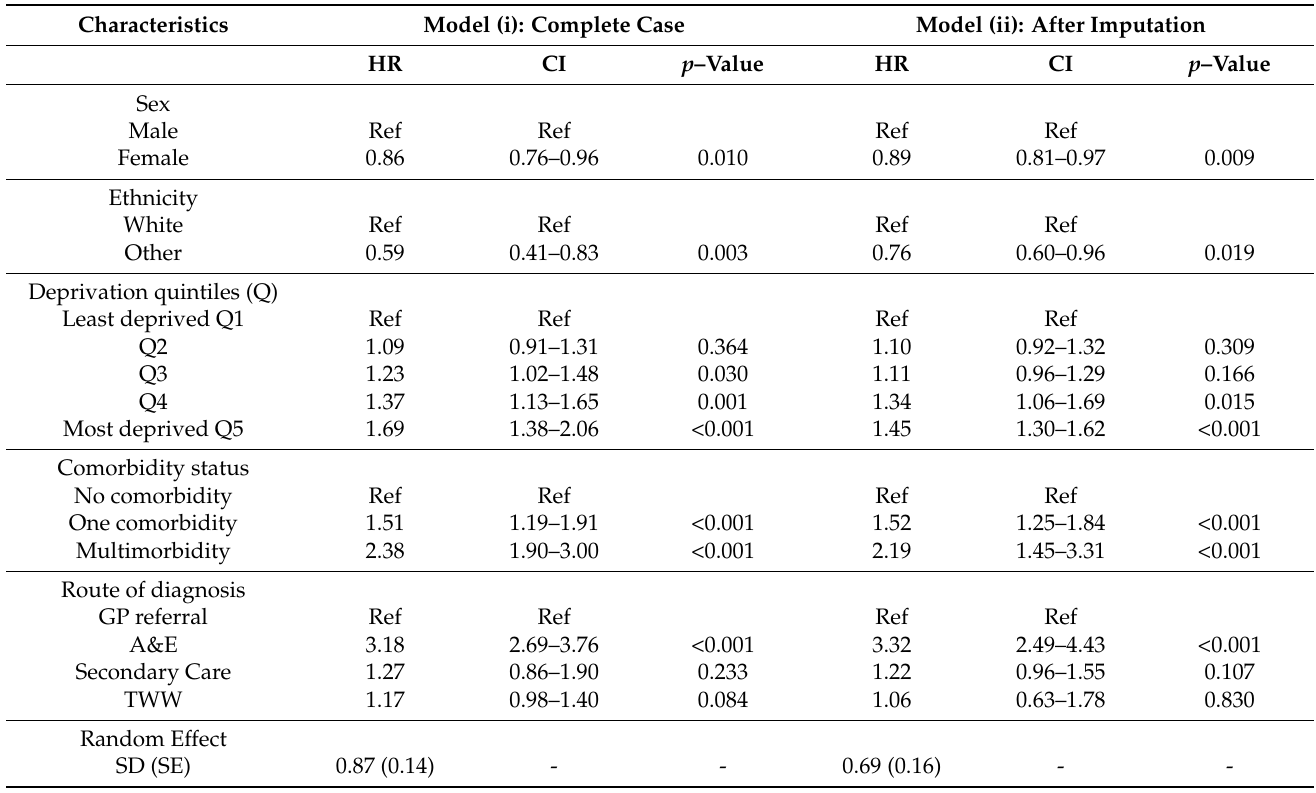
Table 3. Adjusted excess mortality hazard ratios for age, sex, deprivation, comorbidity, cancer subtype, route of diagnosis, ethnicity, and LSOA as random intercept for (i) complete case analysis, and (ii) after multiple imputation for patients ( n = 15,516) diagnosed with follicular lymphoma in England during the period 2005–2013.